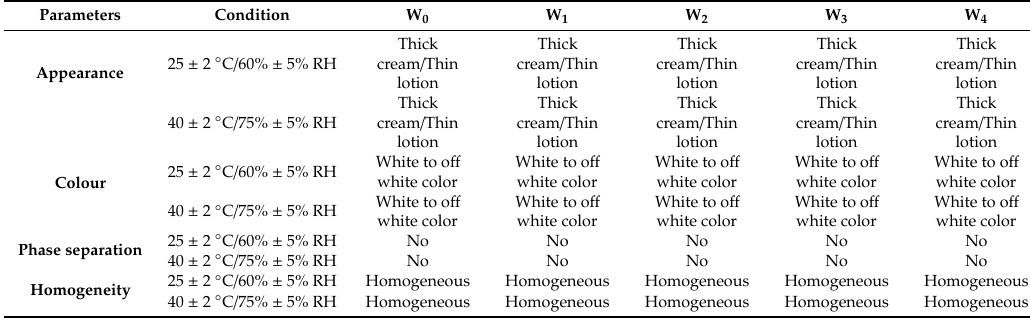
Table 5. Physical stability of the optimized moisturizing cream and